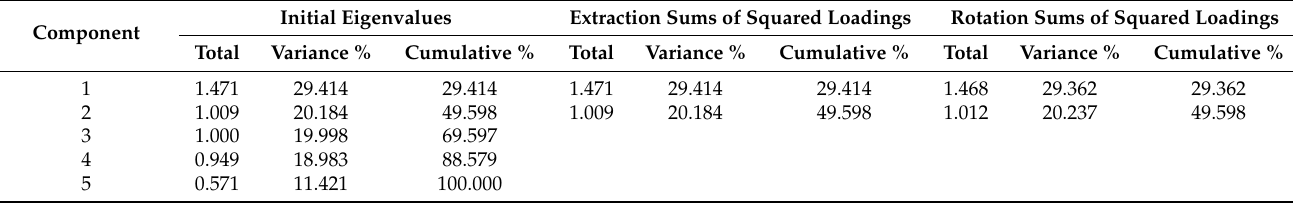
Table 8. Eigenvalues and variance explained with extracted factors of social safety nets (SSN).